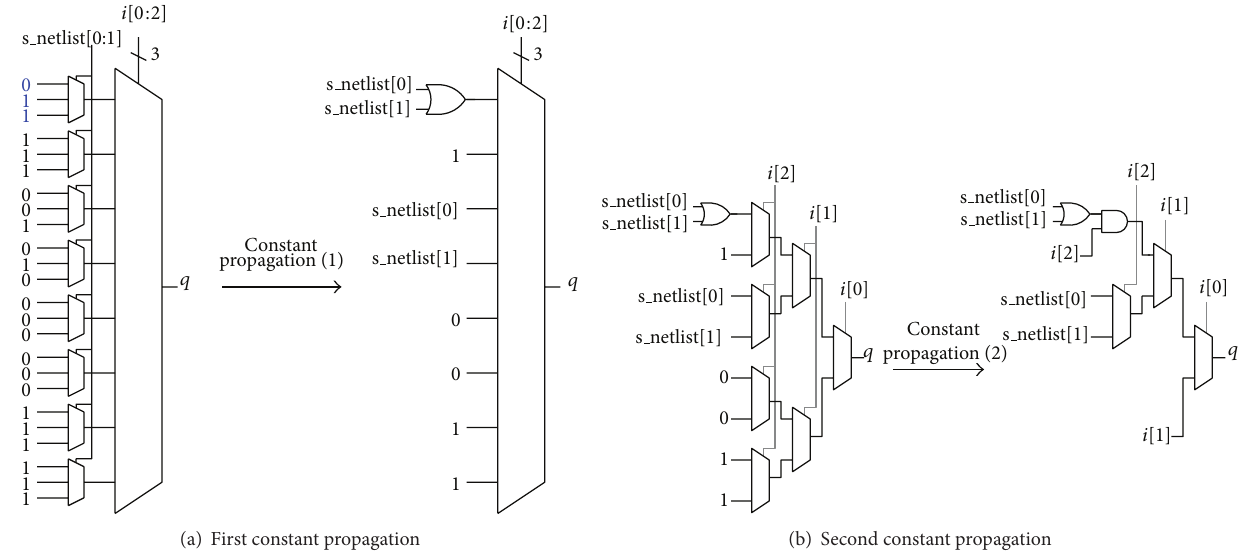
Figure 11: A constant propagation example for 3 netlists (N1, N2, and N3).